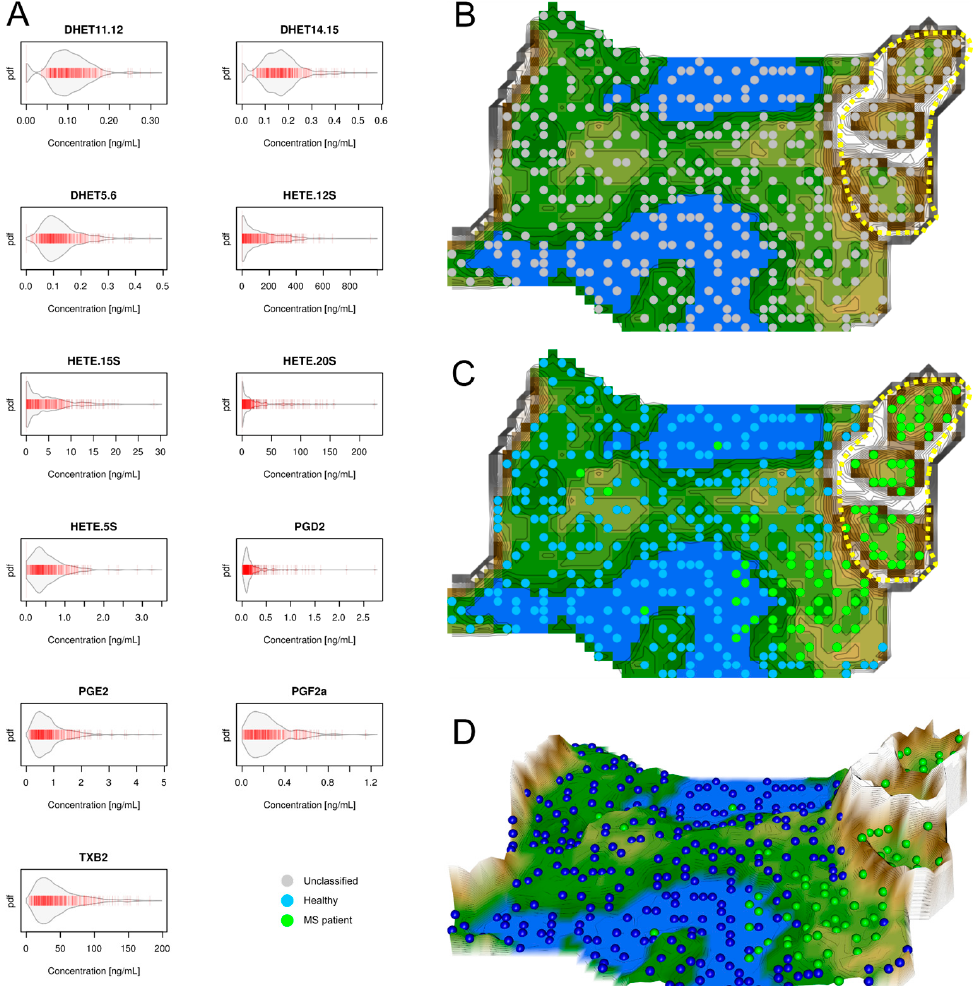
Figure 2. Data structures of eicosanoid serum concentrations: Left part, ( A ) Serum concentrations of d = 11 eicosanoids (raw data). The data are shown in alphabetical order of lipid mediator names. The beanplots [13] show the individual observations as small lines in a one-dimensional scatter plot, surrounded by a mirrored kernel density estimation of the distributions. Each panel displays a single eicosanoids marker. PGD2 = prostaglandin D2, PGE2 = prostaglandin E2, PGF2a = prostaglandin F2a, TXB2 = thromboxane, DHET = dihydroxyeicosatrienoic acid, HETE = hydroxyeicosatetraenoic acid. Right part: U*-matrix visualization of distance and density based structures of the eicosanoid serum concentration ( d = 11 eicosanoid markers) observed in n = 102 multiple sclerosis patients and n = 301 healthy subjects. The figure has been obtained using a projection of the data points onto a toroid grid